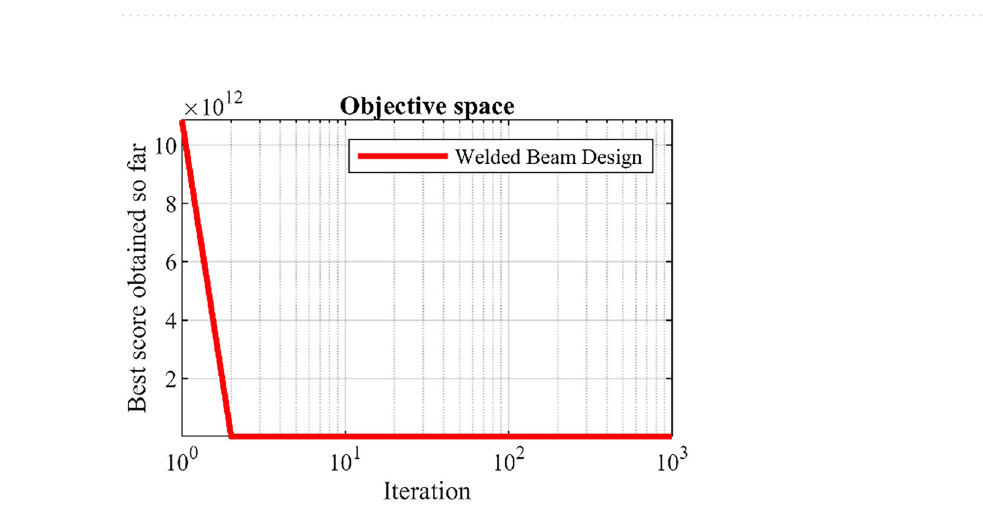
Figure 6. Schematic of welded beam design.